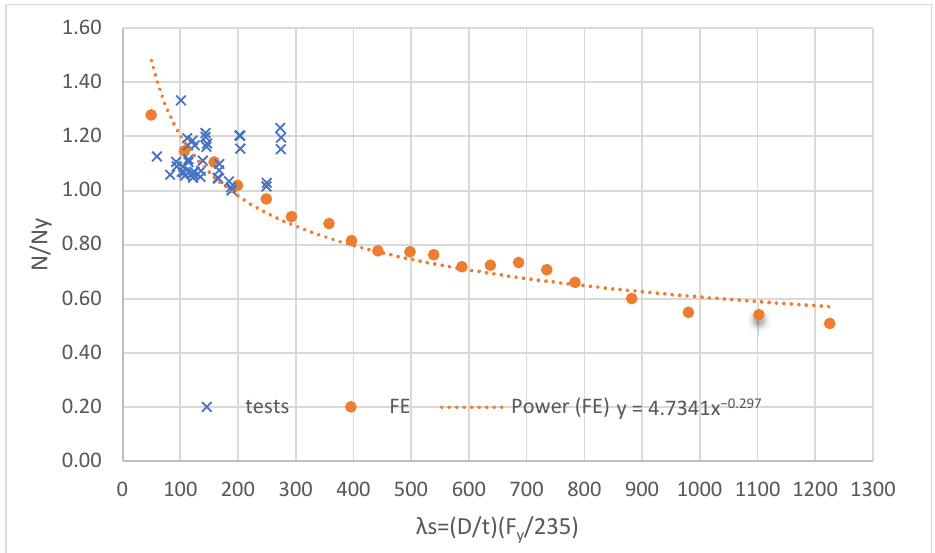
Figure 15. The relation between normalized axial compression and section slenderness of experi- mental results by others and FE by authors for UHSS-S1100.